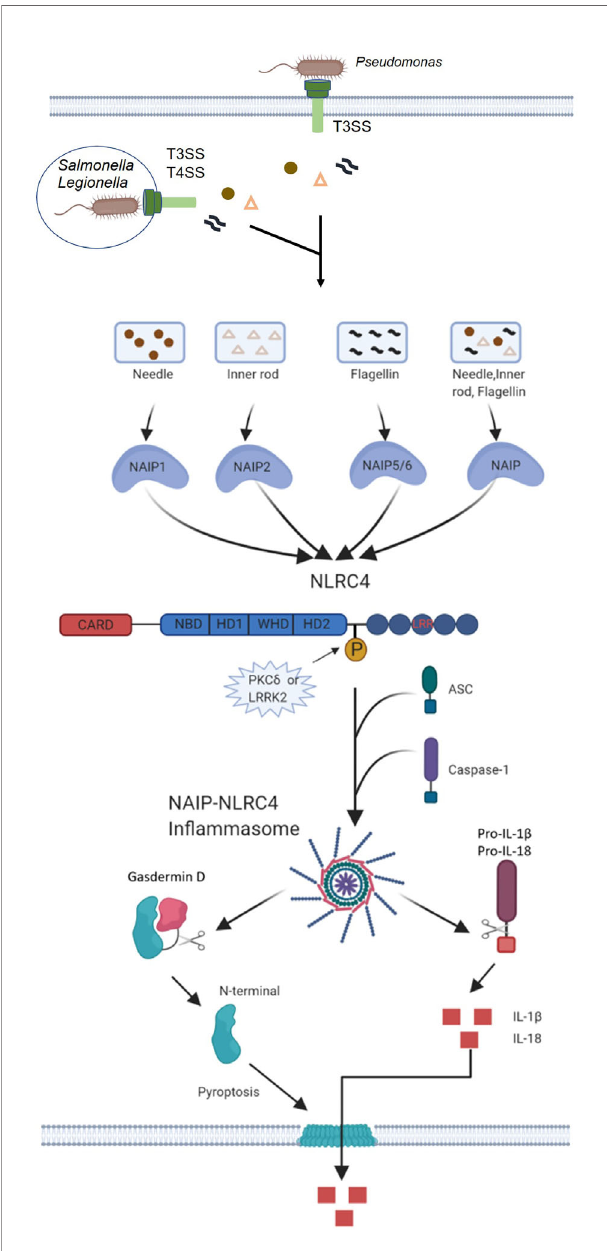
FIGURE 2 | Mechanisms of NAIP-NLRC4 in fl ammasome activation. Infection of macrophages with various Gram-negative bacteria, including S. typhimurium , L. pneumophila and P. aeruginosa , activates caspase-1 via NLRC4. A critical step is the cytosolic delivery of fl agellin or PrgJ-like proteins through bacterial T3SS or T4SS. The needle and inner rod proteins are sensed by mouse NAIP1 and NAIP2, whereas fl agellin is sensed by murine NAIP5 or NAIP6. The needle and inner rod proteins and fl agellin are all sensed by human NAIP. Ligand-bound NAIPs recruit NLRC4 to the same complex to drive activation of the NLRC4 in fl ammasome. NLRC4 acts as an adapter for caspase-1 activation. Caspase-1 cleaves the pore-forming factor GSDMD, whereby the N-terminal domain of GSDMD forms pores in the host cell membrane. Caspase-1 also cleaves the proin fl ammatory cytokines pro-IL- 1 b and pro-IL-18, generating biologically active versions of these cytokines for release through the membrane pores generated by GSDMD. The pores formed by GSDMD also lead to lytic cell death via